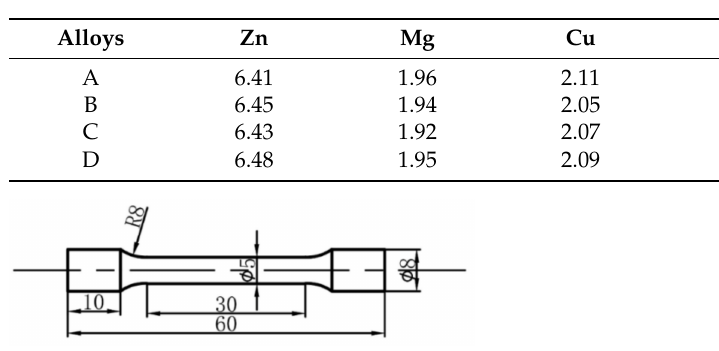
Table 1. Chemical compositions of alloys (wt.%).